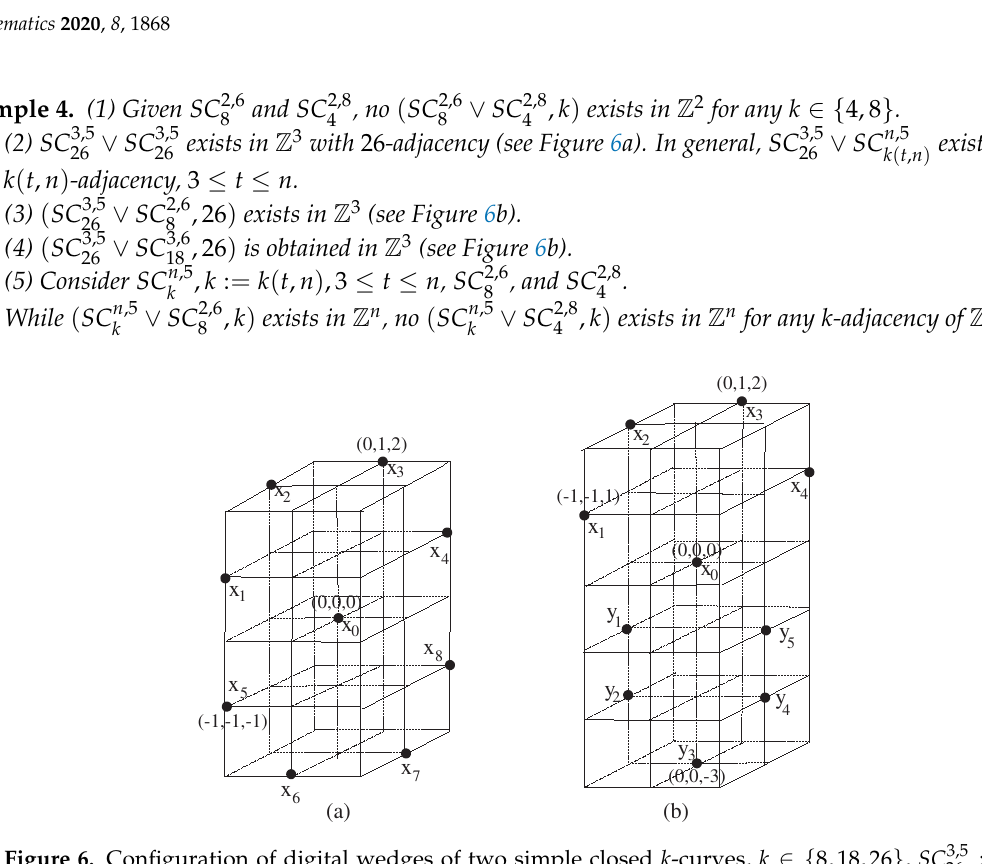
: = 26 ∩ SC 3,5 = { x } . ( b ) ( SC 3,5 ∨ 0 26 26 26 ∩ SC 3,6 = { x } 0 26 18